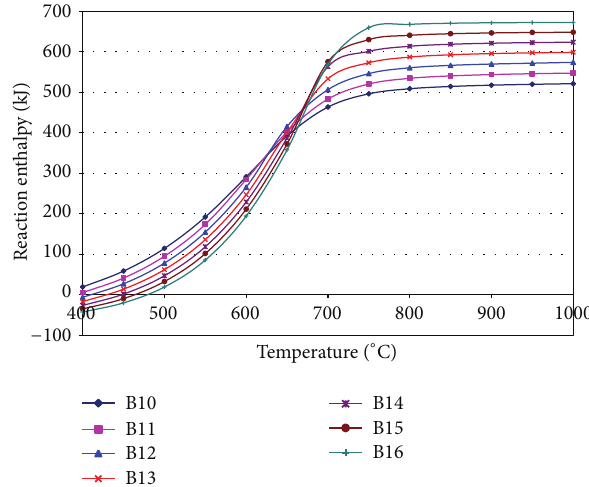
Figure 3: Reaction enthalpy in CR of